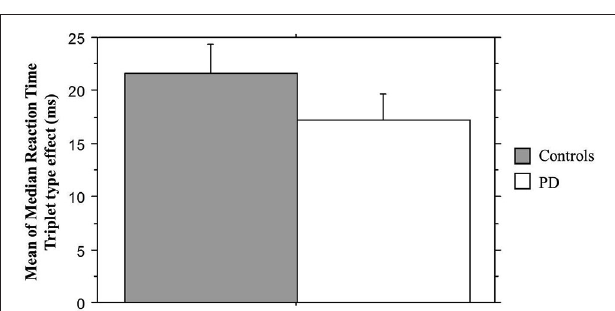
FIGURE 3 | Mean of median reaction time Triplet type effect (RT to Low probability – RT to High probability triplets) by Group . Bars indicate standard error.